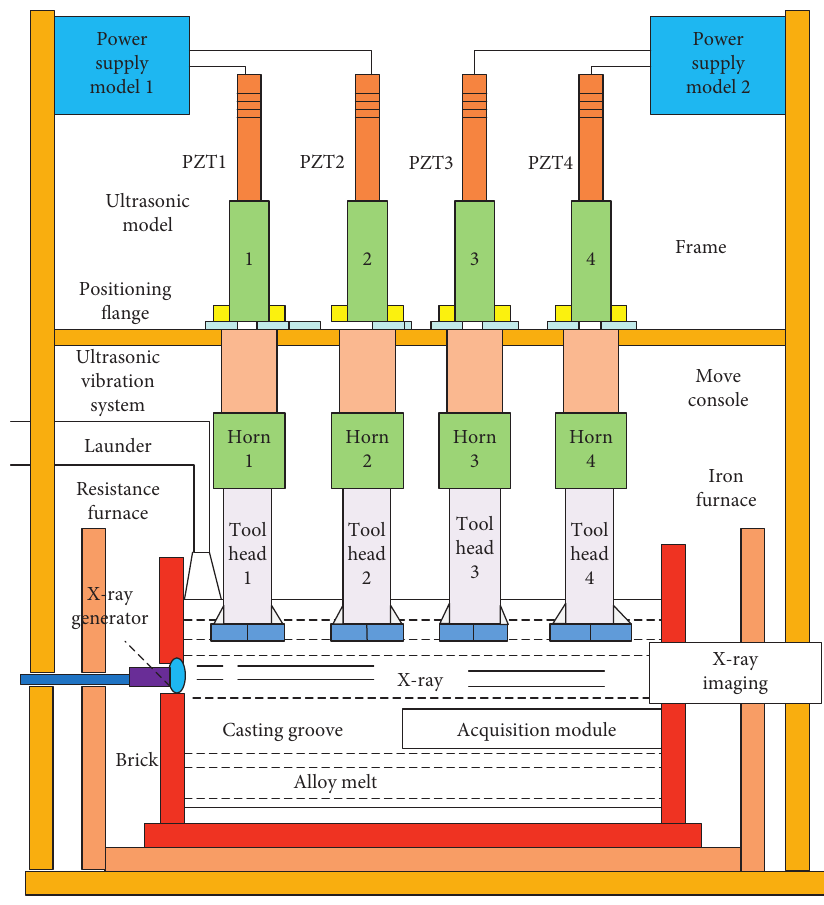
Figure 9: Experimental installation of ultrasonic vibration network with traditional.